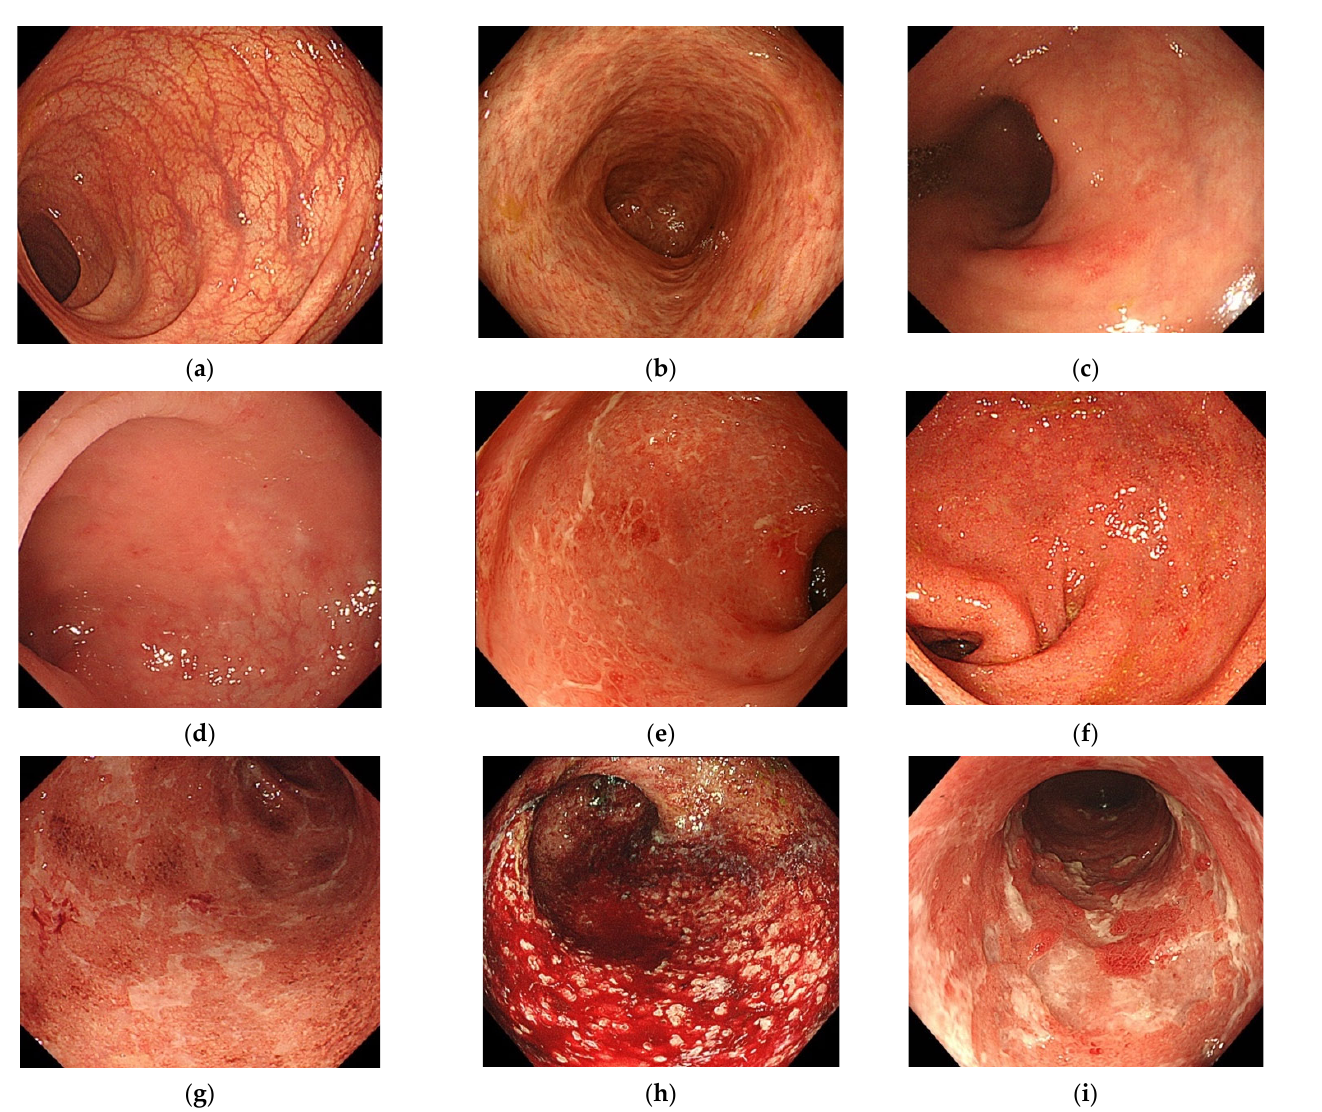
Figure 2. Endoscopic findings in Mayo endoscopic subscore: ( a ) normal, ( b ) inactive disease, ( c ) erythema, ( d ) decreased vascular pattern, ( e ) marked erythema, ( f ) absent vascular pattern, ( g ) erosions, ( h ) spontaneous bleeding, and ( i ) ulcera ‐ tion.